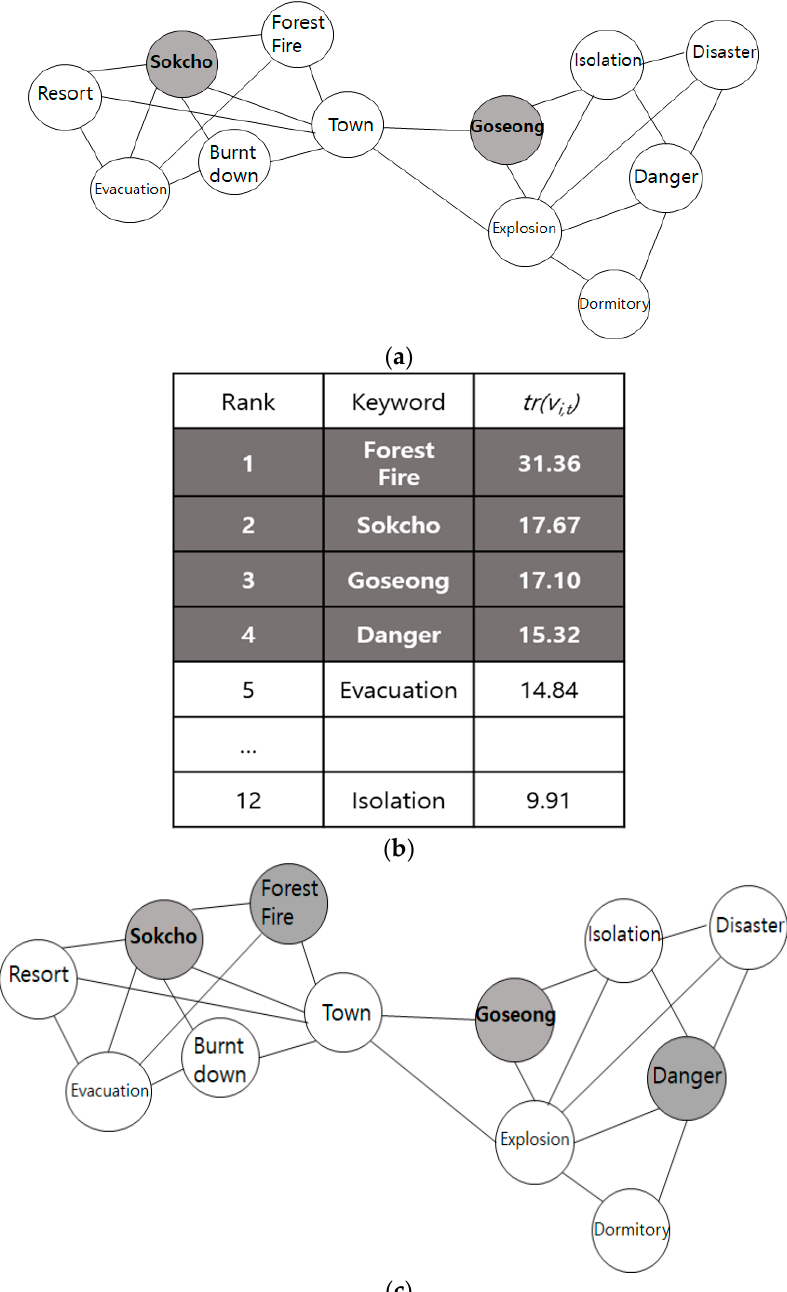
Figure 4. Overall procedure constructing the keyword graph and choosing key nodes: ( a ) an initial keyword graph with labeled regional nodes; ( b ) Text-Rank scores each keyword; ( c ) key nodes assigned to the keyword graph.